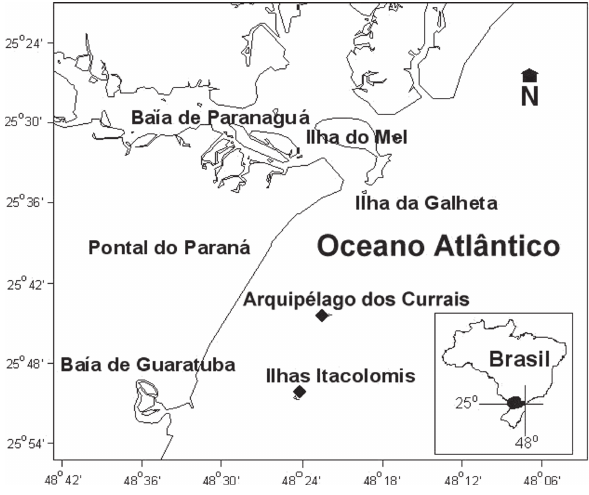
Figura 1. Mapa da localização das estruturas recifais ( (cid:2) ) na plataforma rasa do litoral do